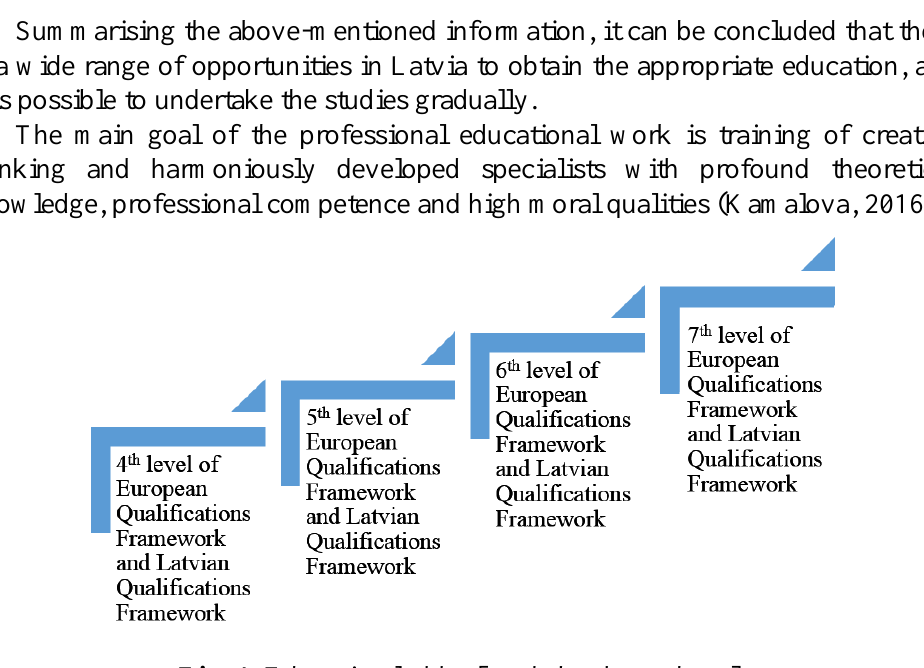
Fig. 4. Education ladder [made by the